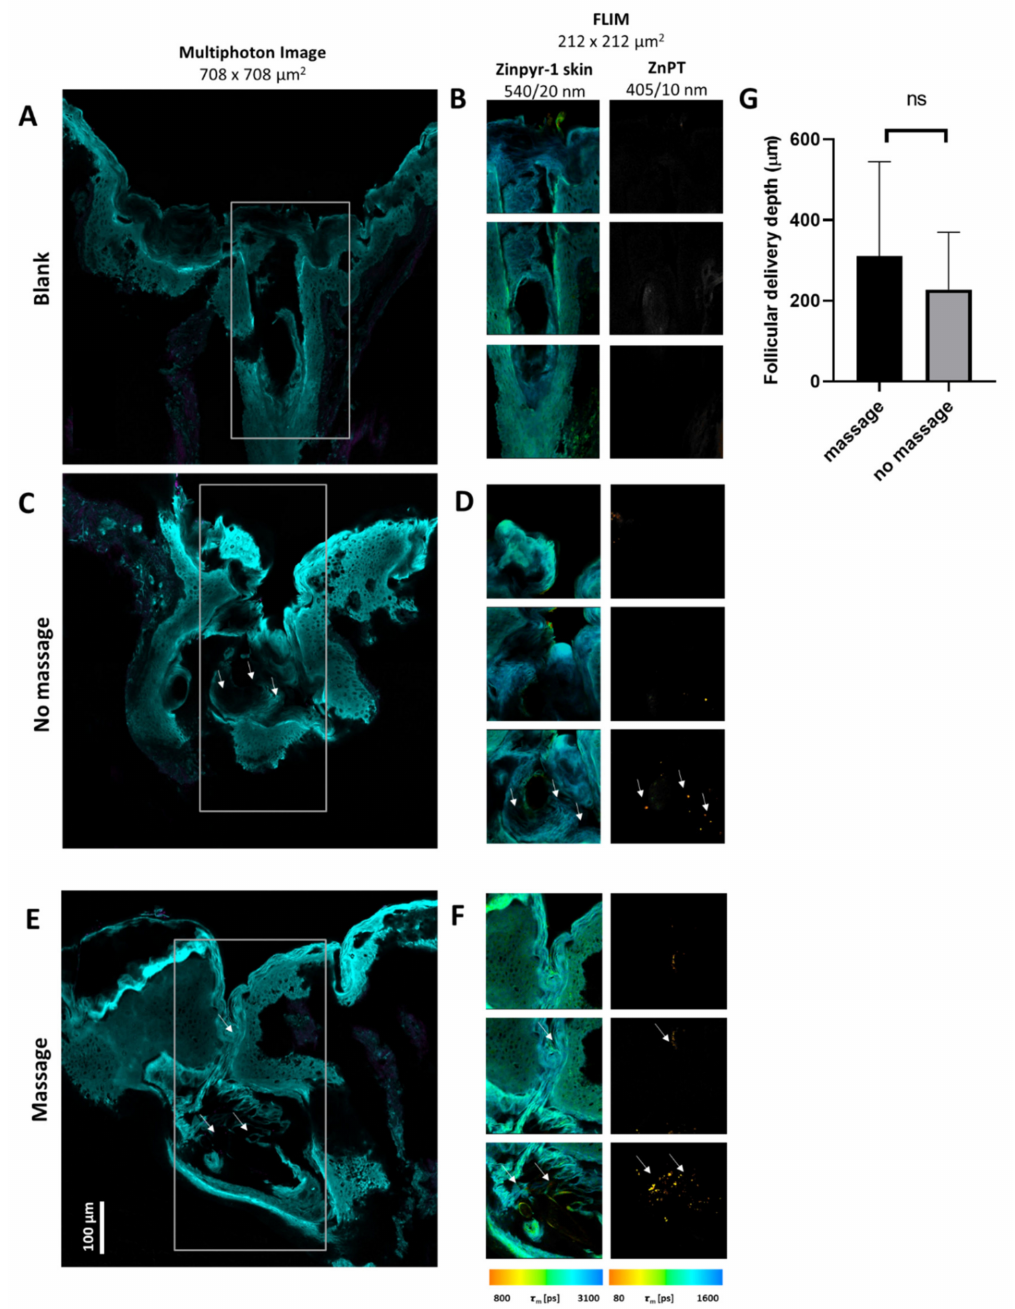
Figure 3. Follicular delivery of ZnPT from the positive and negative controls . ( A ) MPM image of a blank negative control with ( B ) the corresponding FLIM images along the length of the follicle. ( C ) MPM image of the no-massage positive control dosed with aqueous ZnPT 2% w / v and ( D ) the corresponding FLIM images along the length of the follicle. ( E ) MPM image of the 2 min massage positive control dosed with aqueous ZnPT 2% w / v and ( F ) the corresponding FLIM images along the follicle. For MPM images ( A , C , E ), two excitation wavelengths were used: two-photon excitation at 800 nm with emission collected at 395–420 nm (pink) and one-photon excitation at 488 nm with emission collected at 520–560 nm (blue). Scale bar = 100 µ m. The parameters for the FLIM images ( B , D , F ): two-photon excitation at 740 nm with emission collected using a 405/10 nm bandpass filter for ZnPT and 540/20 nm bandpass filter for Zinpyr-1. FLIM images are pseudo coloured to the average time-weighted lifetime τ m [ps]. ( G ) Student’s t -test for follicular delivery depth for massage and no-massage application. Arrows indicate position of deposited ZnPT